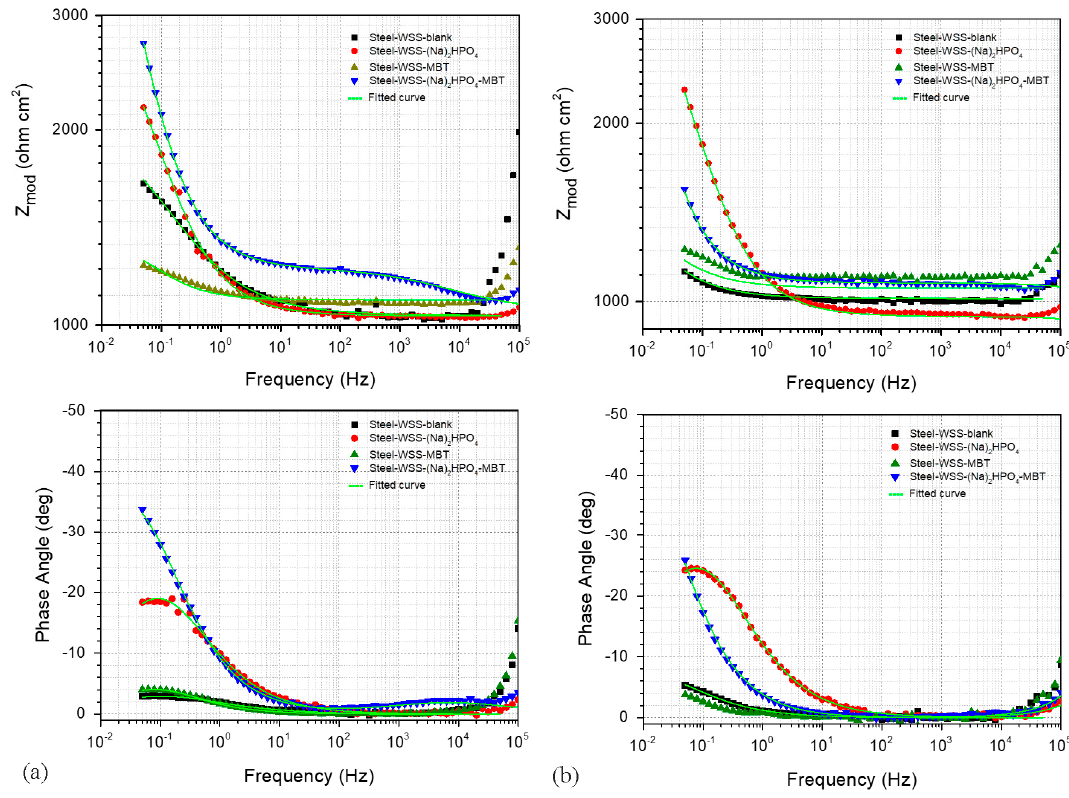
Figure 19. Electrochemical impedance spectroscopy (EIS) plots recorded for mild steel panels